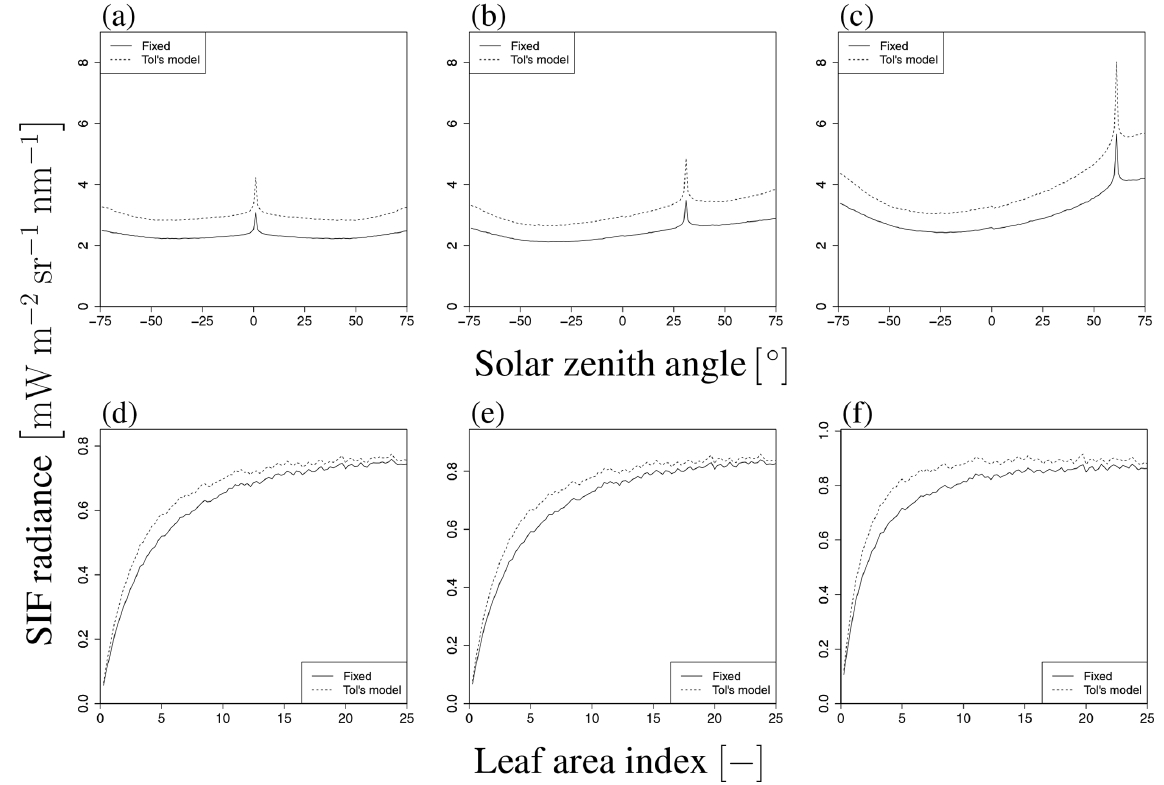
Figure 20. Comparison of SIF radiance with different φ f (constant and from Tol’s model). Upper and lower figures indicate SZA dependency (LAI = 3 . 0) and LAI dependency (SZA of 20 ◦ ), respectively. The VZA values are 0 ◦ (a, d) , 30 ◦ (b, e) , and 60 ◦ (c, f) . The solid line indicates the case of constant φ f ( = 0 . 01). The dashed line indicates the result of Tol’s model, where φ f depends on APAR L , as shown in Fig. 8.